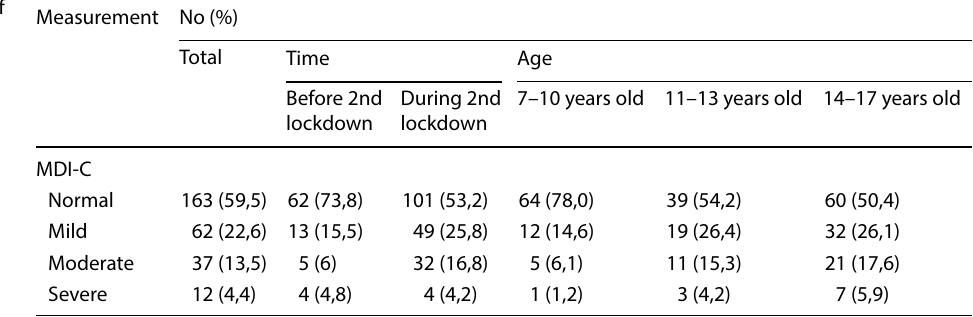
MDI-C Multiscore Depression Inventory for